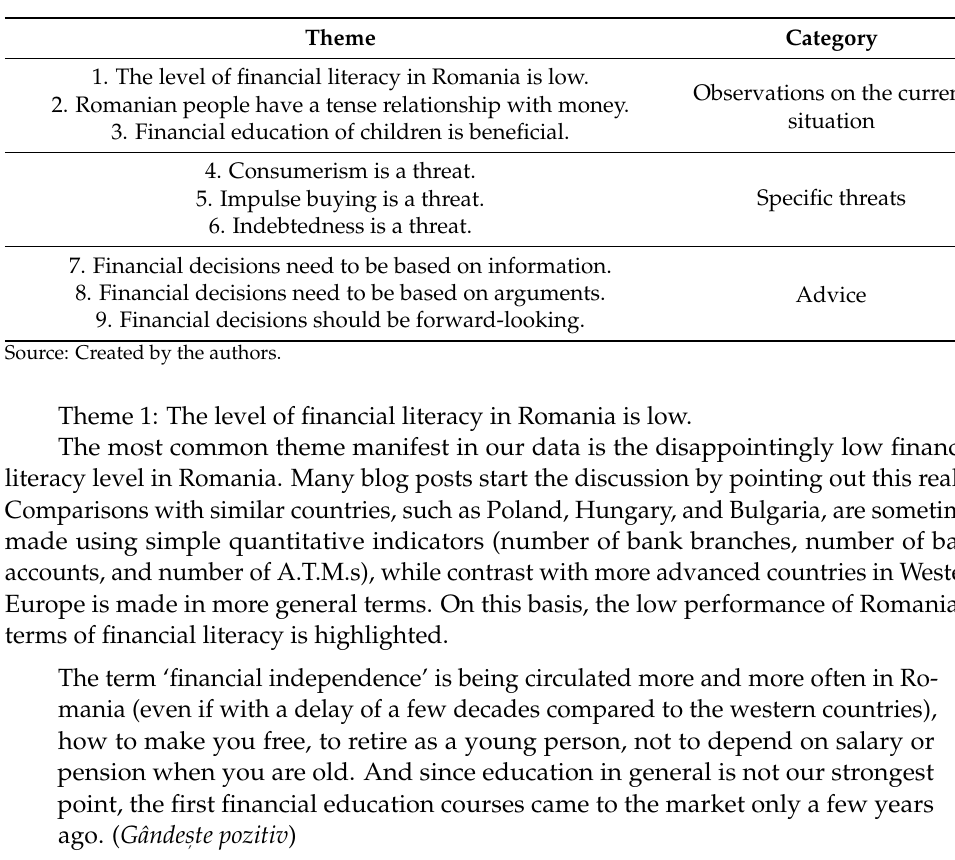
Table 2. Manifest Themes in Financial Education Projects in